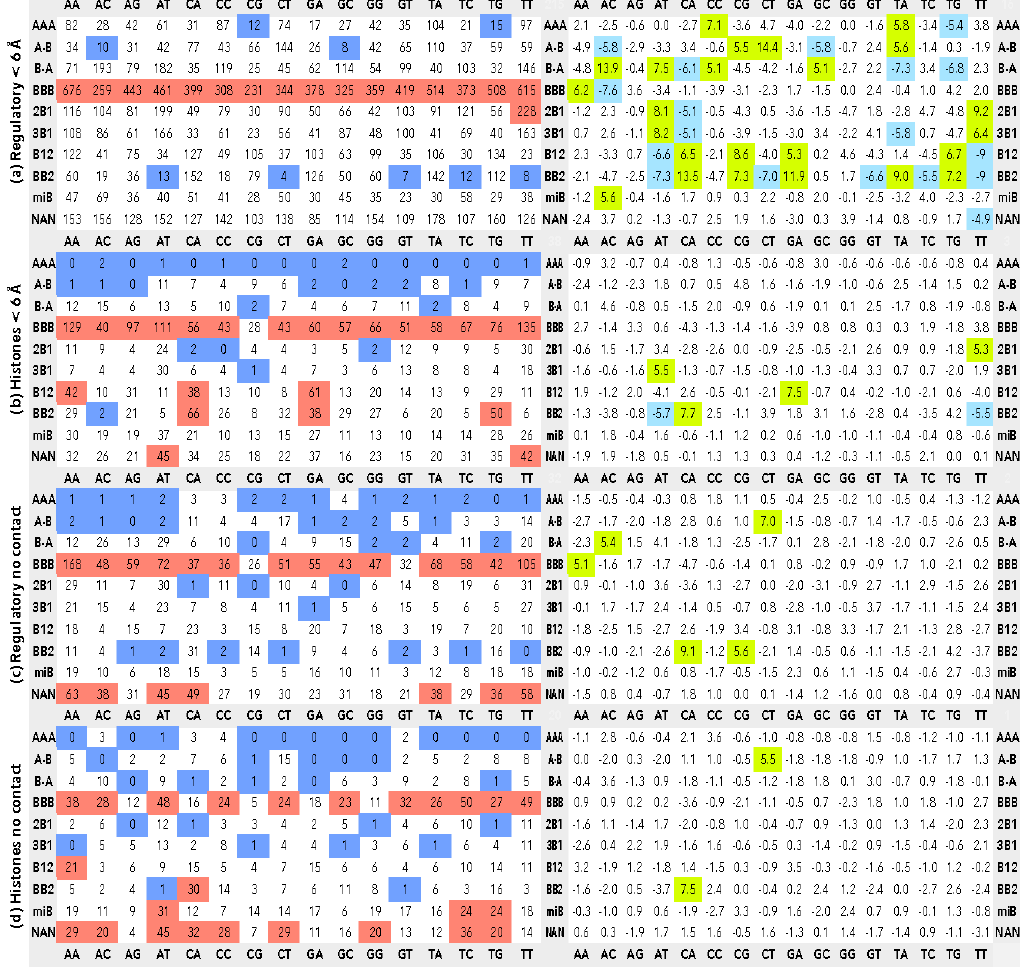
Figure 1. The associations between dinucleotide sequences and structures classified as CANA letters. The matrices in the left column show the instances of the observed CANA/sequence associations, the right column the corresponding standardized Pearson residuals (SPR). Matrices ( a ) and ( c ) show statistics for DNA in complexes with regulatory proteins, ( b ) and ( d ) for DNA in the nucleosome core particles; ( a ) and ( b ) concerns dinucleotides in contact with proteins. Dinucleotides in contact with proteins are closer than 6.0 Å from an amino acid. Matrices ( c ) and ( d ) show data for dinucleotides not in contact with protein. The red highlight shows CANA/sequence associations with twice as many observations as the average for the dinucleotide group; the blue highlights associations smaller than 15% of the average. Green (blue) highlights show SPR with probability less than 1.0 × 10 − 6 for over- (under-) populated associations. Editable version of the figures is in Supplementary Table S3 in the XLSX format so that the color highlights can be modified.